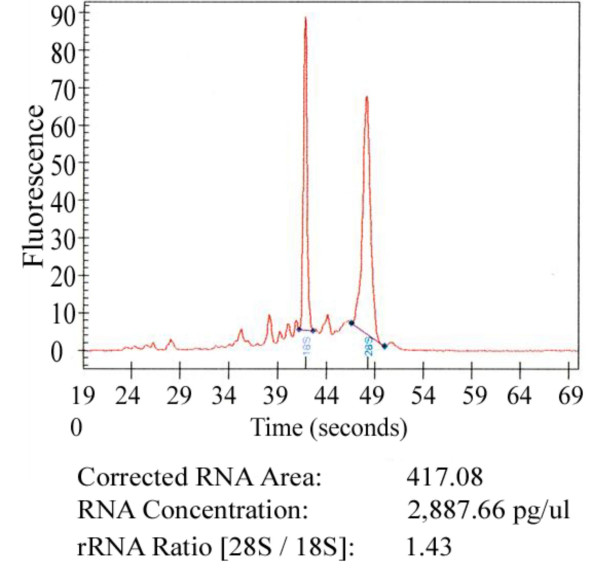
Representative Bioanalyser Picochip plot of RNA isolated from one biopsy, with a 28S/18S ratio of 1.43.